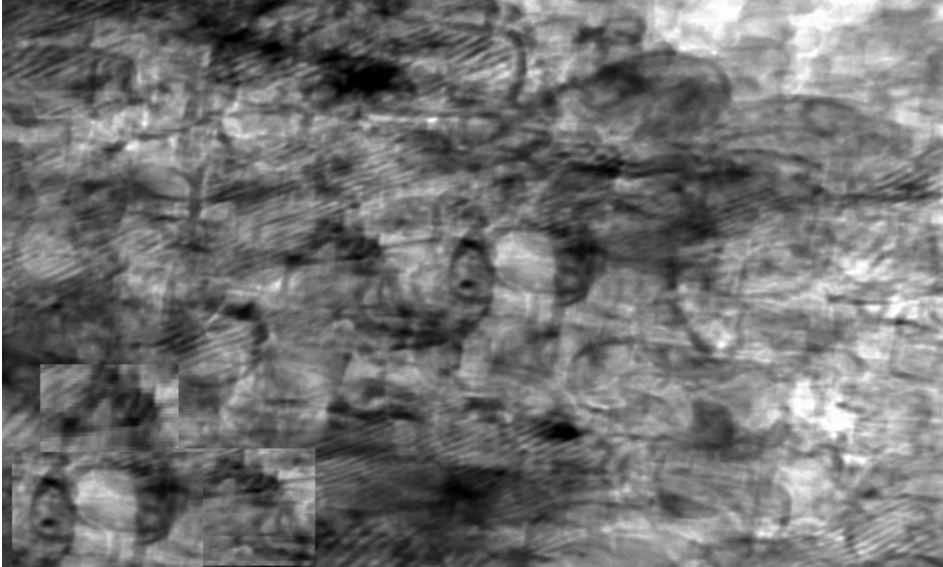
Figure 4. Transmission electron microscope (TEM) image of chitosan nanoparticles (CSNPs). Fourier Transform Infrared Spectroscopy Analysis Fourier transform infrared spectroscopy analysis (FTIR) of (CSNPs) is shown in Figure 5; it is clear that FTIR showed the intense and wide band at 3220 cm − 1 related to the vibration of -OH group, the characteristic peaks at 1513 cm − 1 and 1040 cm − 1 are due to the vibration of C=O.